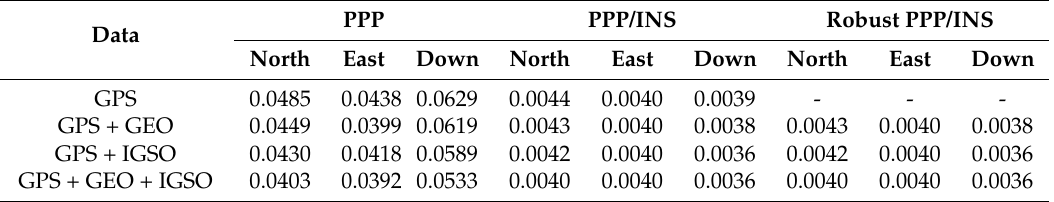
Figure 10 . Velocity offsets ( a ) of PPP, PPP/INS, and robust PPP/INS tight integration models, and attitude offsets ( b ) of PPP/INS with and without R-EKF. Table 4. Velocity RMS of PPP, PPP/INS tight integration, and robust PPP/INS tight integration (unit: m).